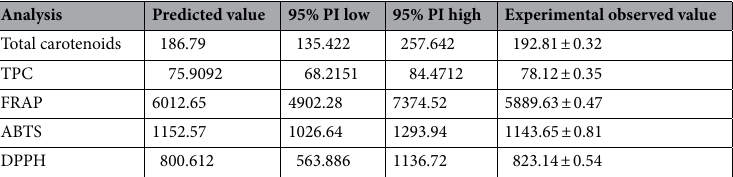
Table 6. Representation of predicted and experimental values of the responses at optimized MAE conditions.